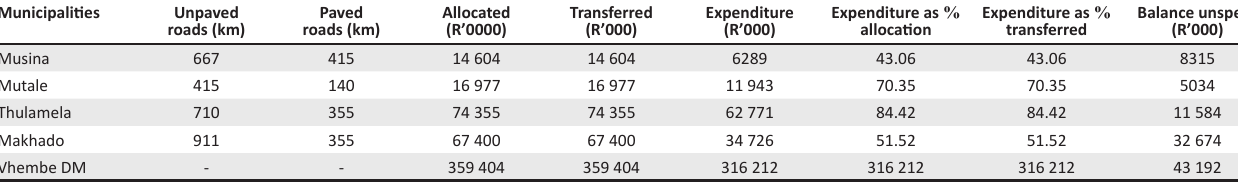
TABLE 2: Municipal grant expenditure per municipality in Vhembe district in 2013. Municipalities Unpaved roads